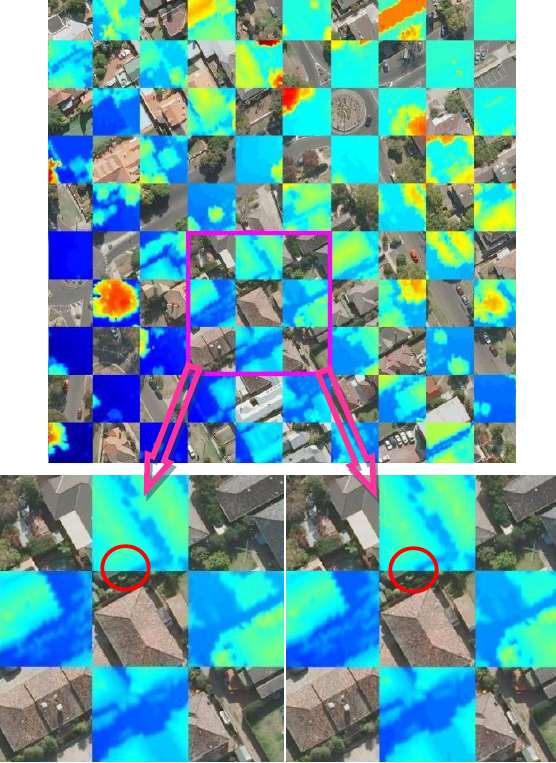
Figure 7. Registered orthoimage and LiDAR DSM image for a single tile(top) and enlarged view of highlighted area before registration (left), after registration (right).